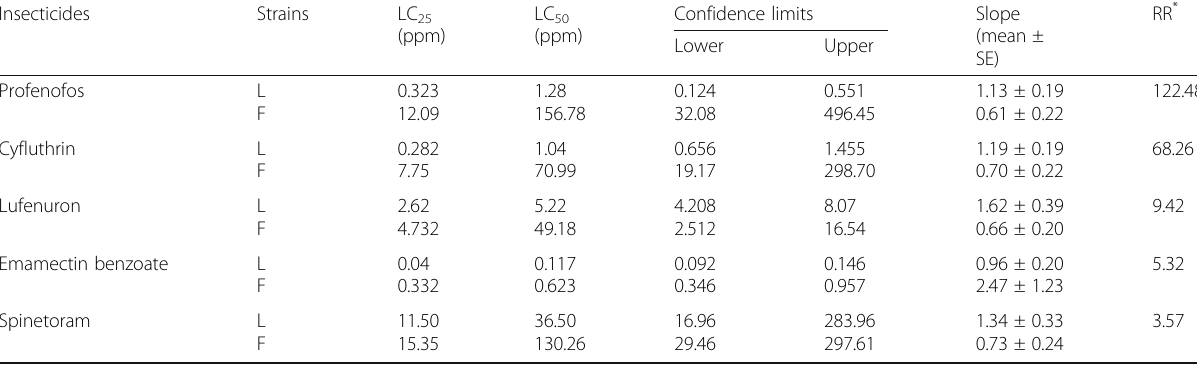
Table 1 Toxicity of the tested compounds against 4th larval instar of S. littoralis Insecticides